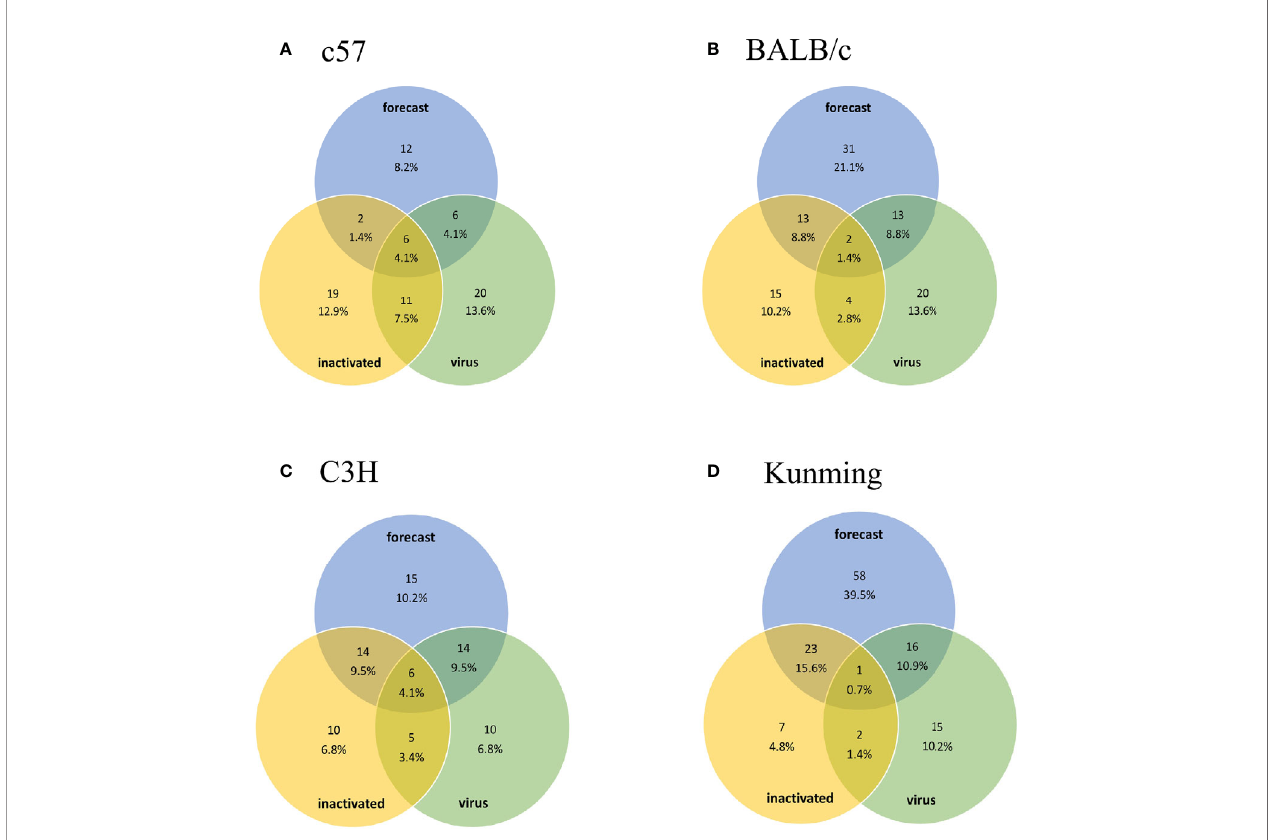
FIGURE 1 | Venn diagram of predicted epitopes and epitopes obtained experimentally using inactivated HTNV vaccine and live virus. The number of overlapping epitopes and their proportions are shown. Groups (A – D) are the results obtained from C57, BALB/c, C3H, and Kunming mice, respectively. The percentage represents the ratio of the number of epitopes to the total number of experimentally determined epitopes (147 peptides including 83 Gn and 64 Gc